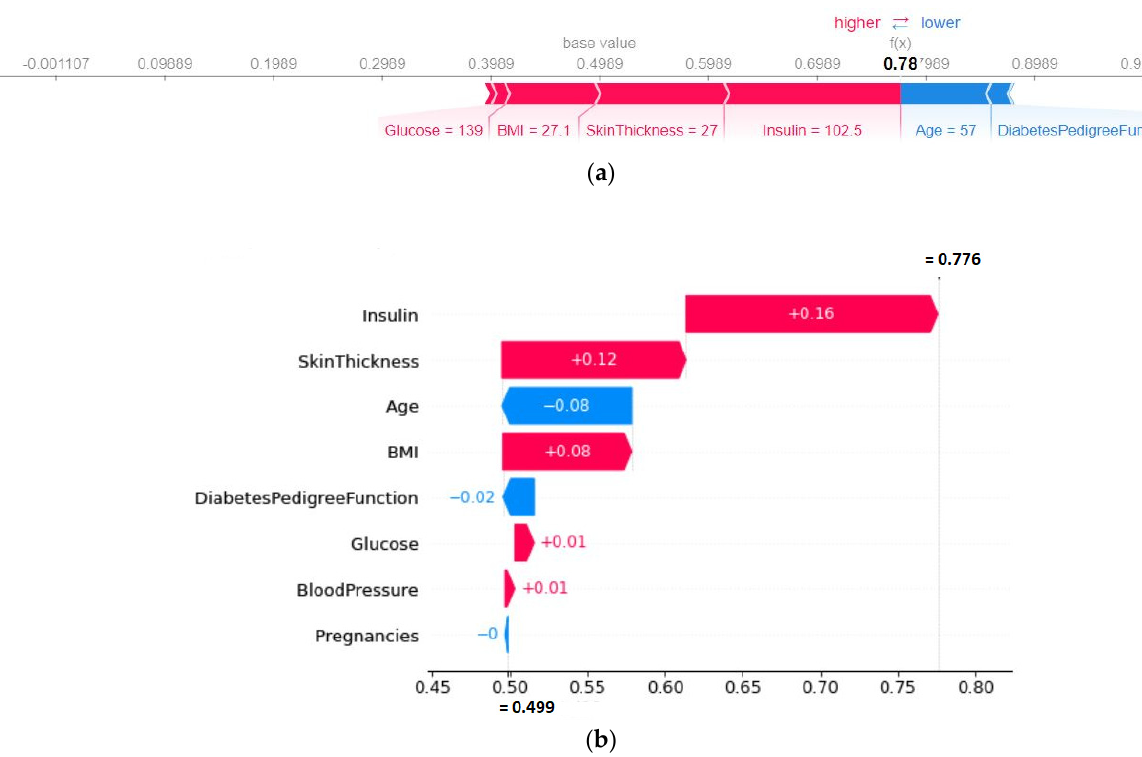
Figure 8. ( a ) SHAP force plot and ( b ) water plot for a test sample of the voting classifier using the five-fold.